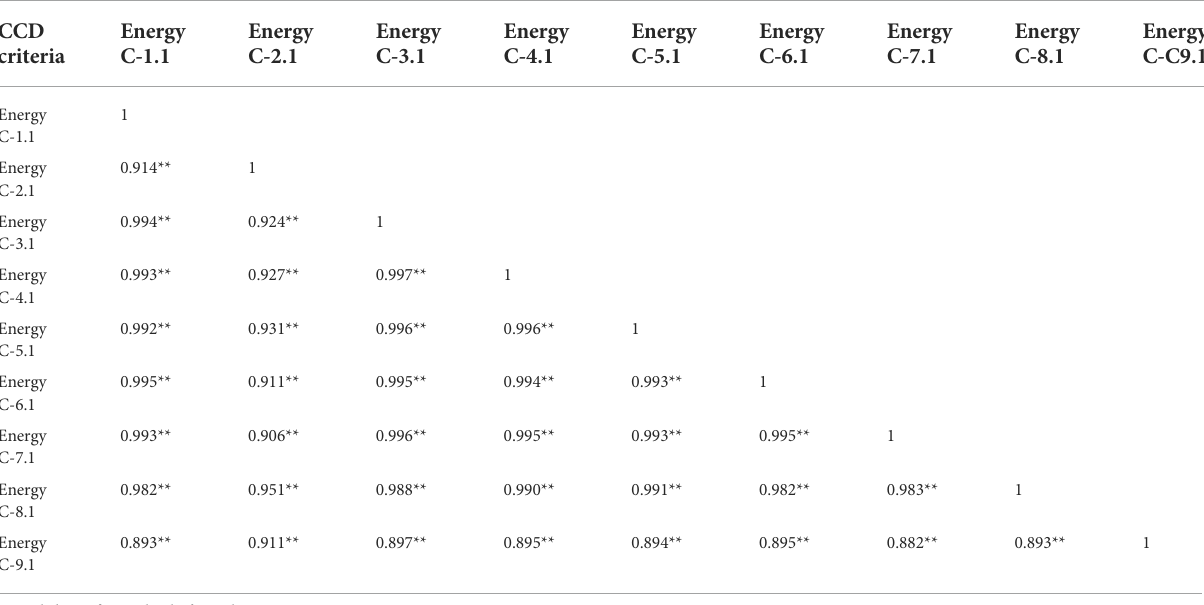
TABLE 3 Correlation between energy sector GC-1 ’ s CCD criteria (EC1.1-EC9.1).